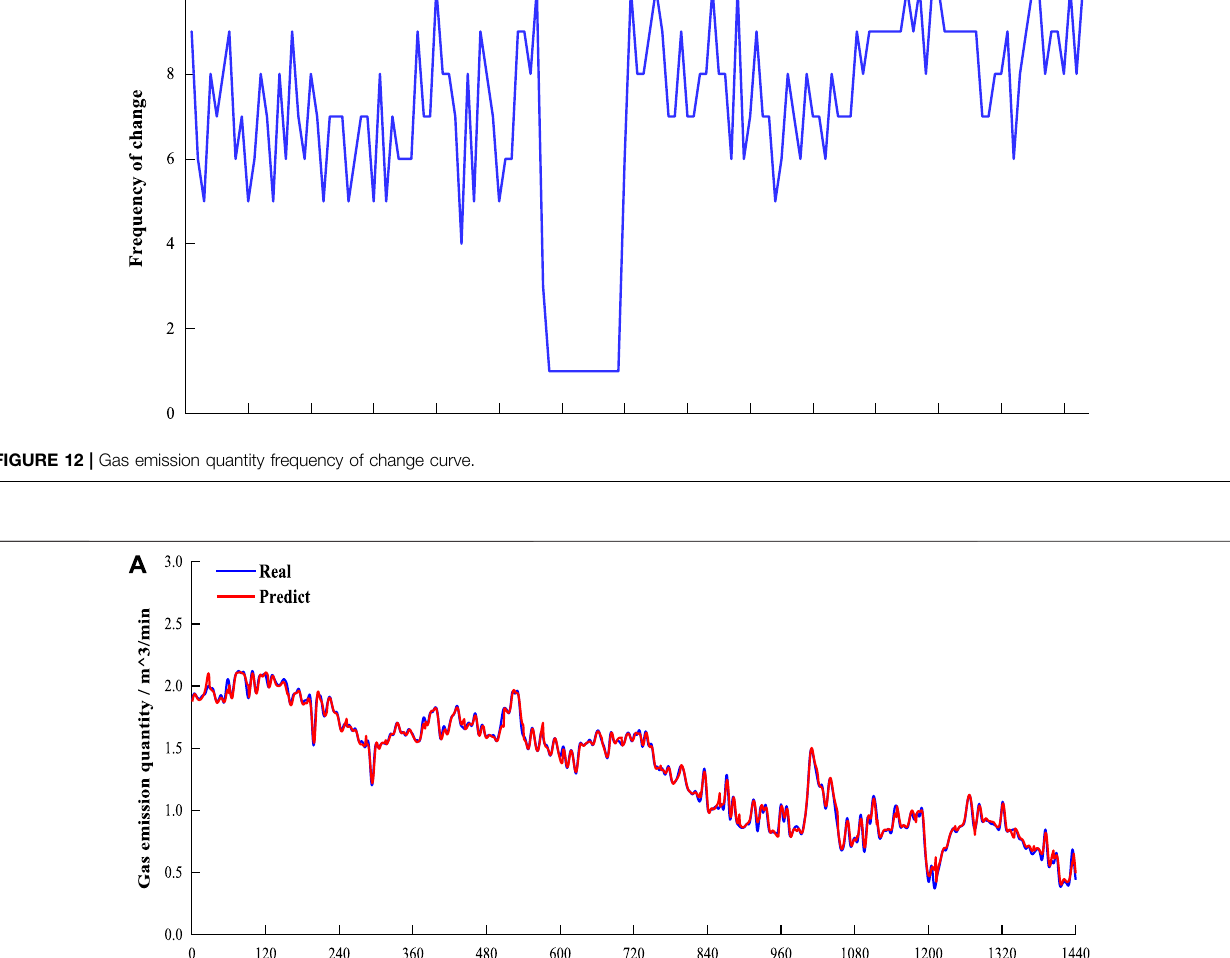
Frontiers in Earth Science |